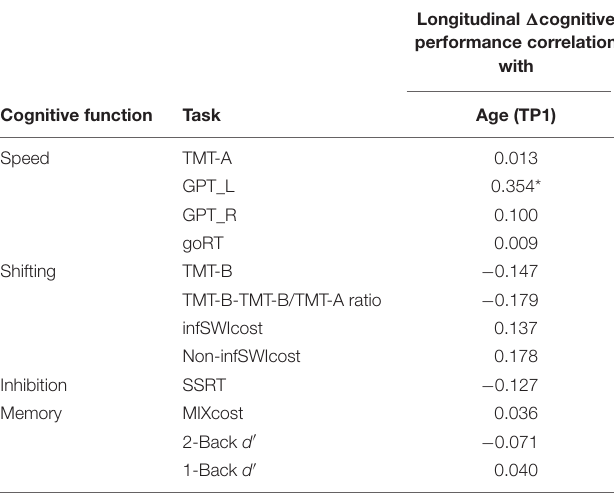
TABLE 5 | The correlation between age at TP1 and cognitive performance (including processing speed and cognitive control function) for the longitudinal data ( n =